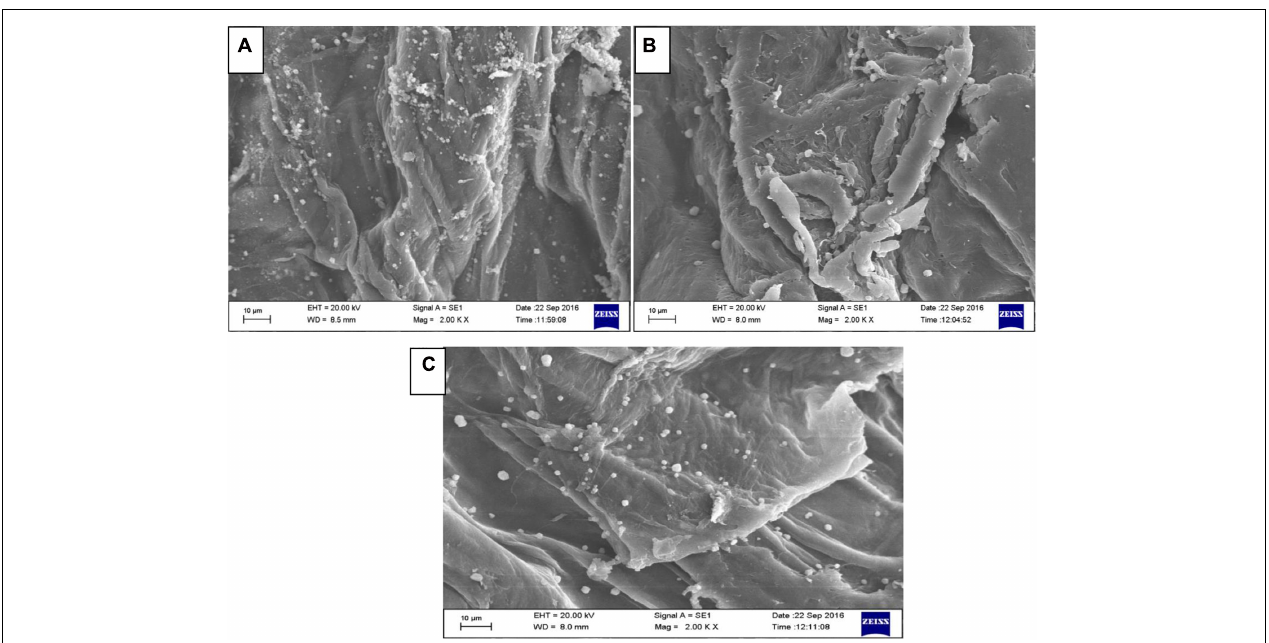
FIGURE 4 | Field emission scanning electron microscopy of chitosan irradiated at three different irradiation ranges (A) 0 kGy, (B) 10 kGy, and (C) 20 kGy irradiation source.